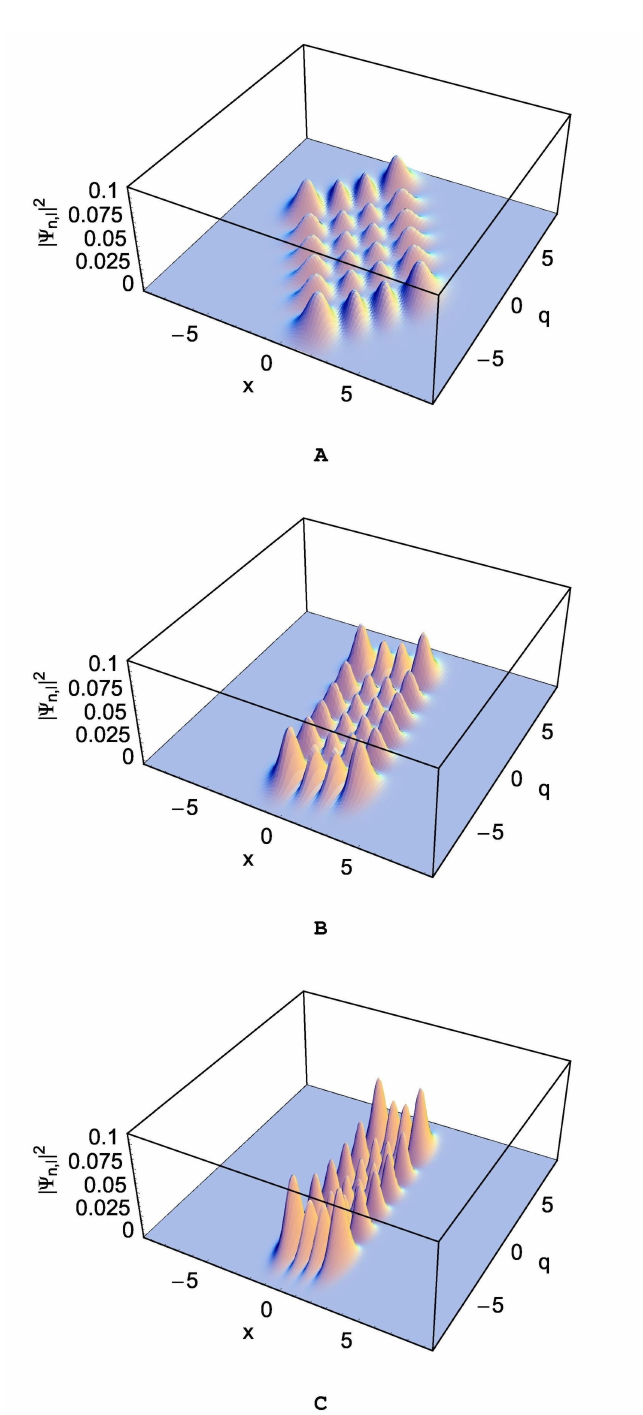
Figure 2. The probability density | Ψ n , l ( x , q , t ) | 2 in the original system for several different values of ω with the choice of ( m , L ) = (1.0, 0.5) under the limit λ ( t ) = λ 0 . This is associated to the wave functions given in Equation (19) with Equations (20), (21), (24), (25), (28), and (29). The values of ( ω , Ω ) are (0.5, 0.49) for ( A ), (1.0, 0.49) for ( B ), and (2.0, 0.49) for ( C ). We used ( n , l ) = (3, 5), ¯ h = 1, and λ 0 =